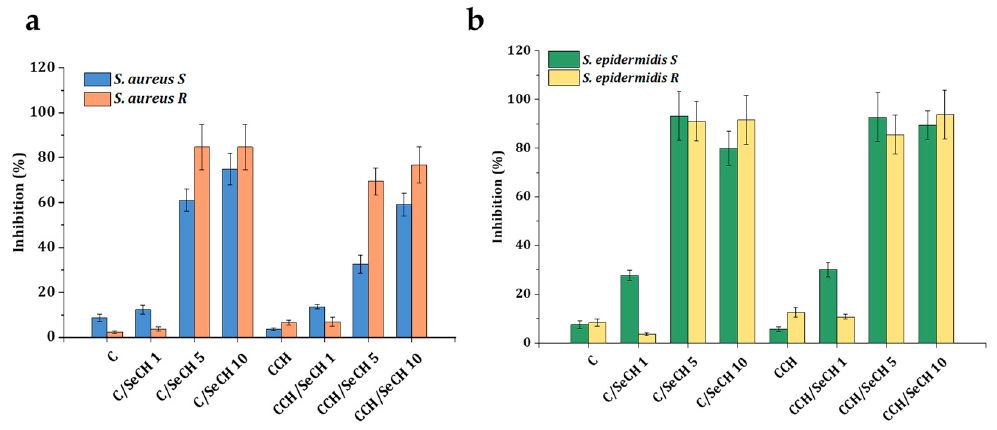
Figure 11. Bacterial growth inhibition of sensitive (S) and resistant (R) clinical isolates: S. aureus ( a ) and S. epidermidis ( b ). Bacterial samples were incubated for 24 h in media with scaffolds of Se concentrations of 1, 5 or 10 ppm.